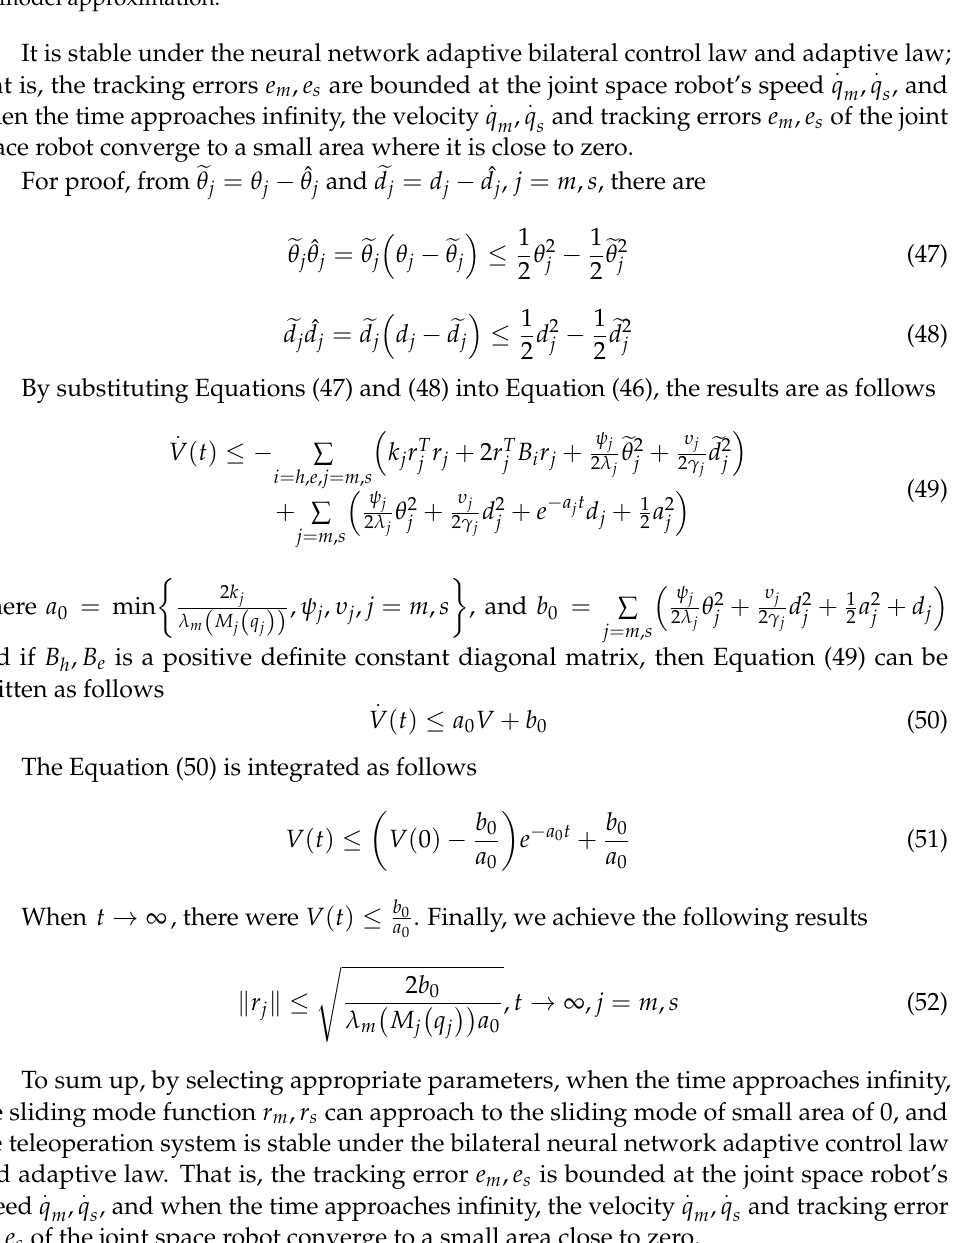
Figure 3. Adaptive neural network control block diagram of time delay teleoperation system based on model approximation.